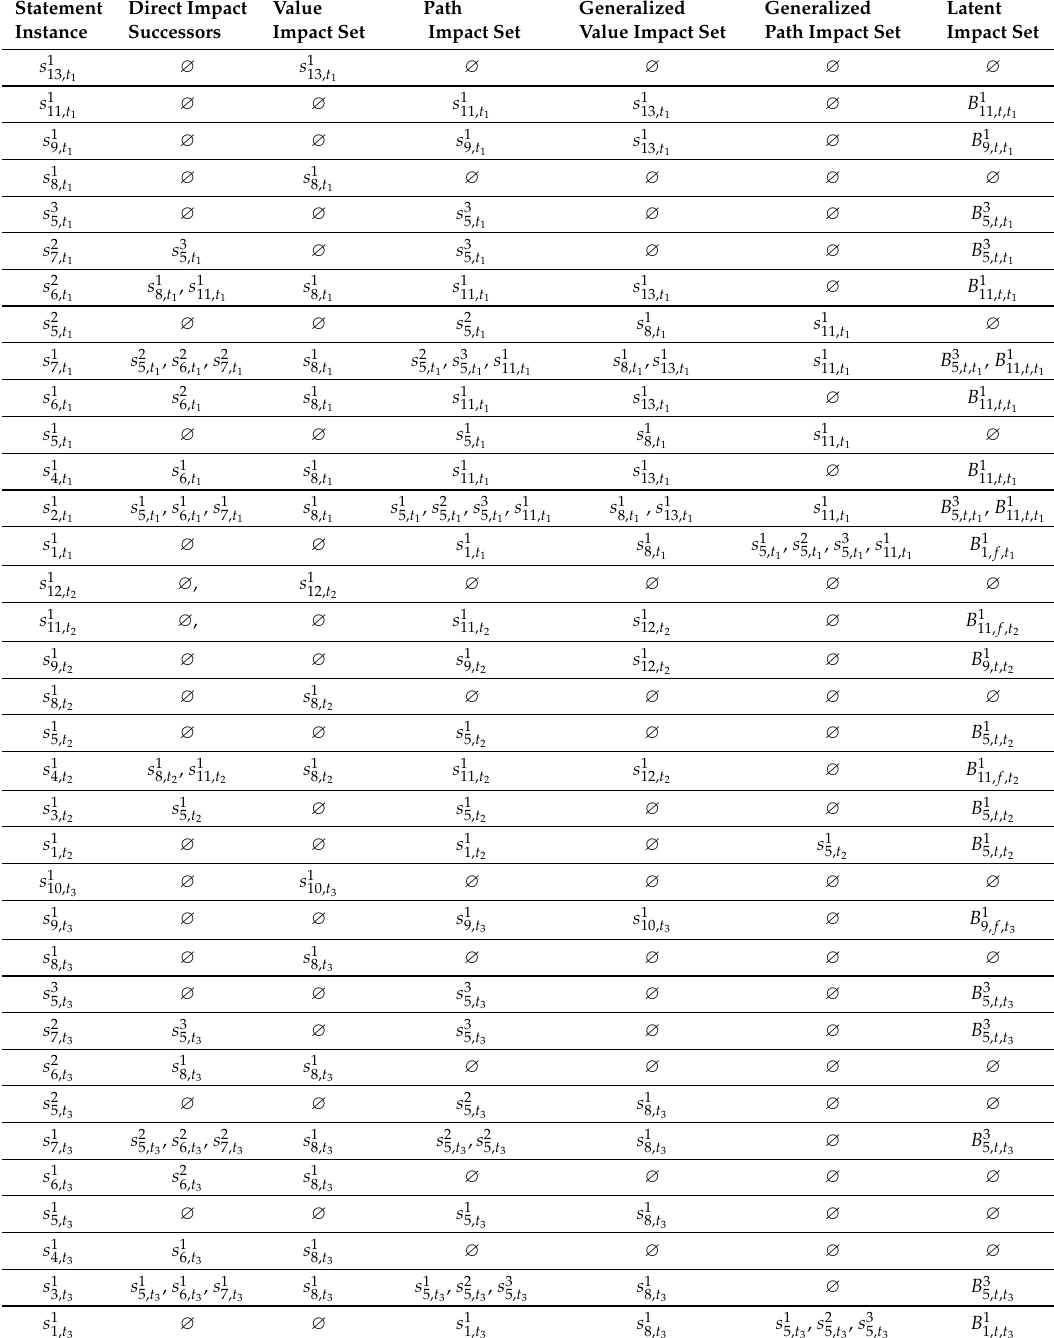
Table 3. The first five impact sets of all statement instances in Program